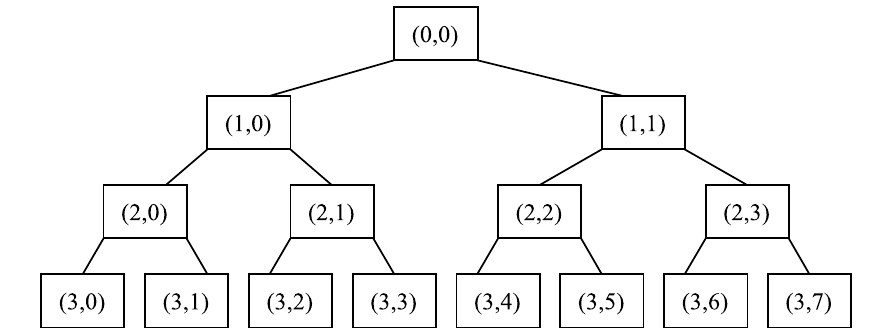
Fig. 1. The binary tree structure of three layer wavelet packet